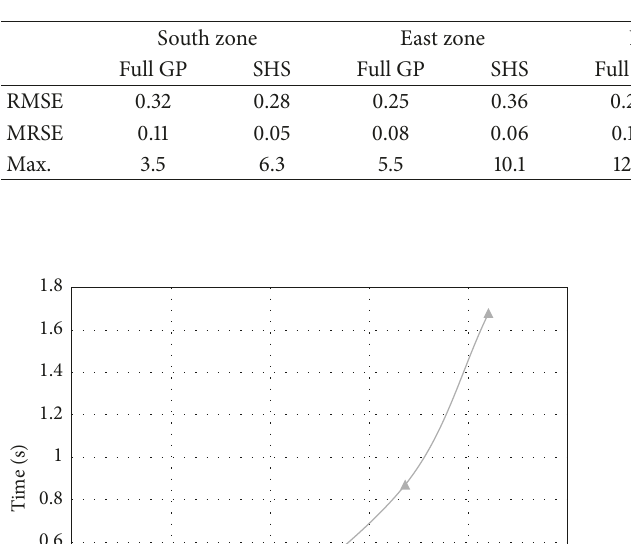
Figure 10: Clustering of the training data for the west zone using (a) 𝐾 -means algorithm, (b) GMM algorithm, and (c) hierarchical algorithm. Table 4: Prediction error statistics per zone